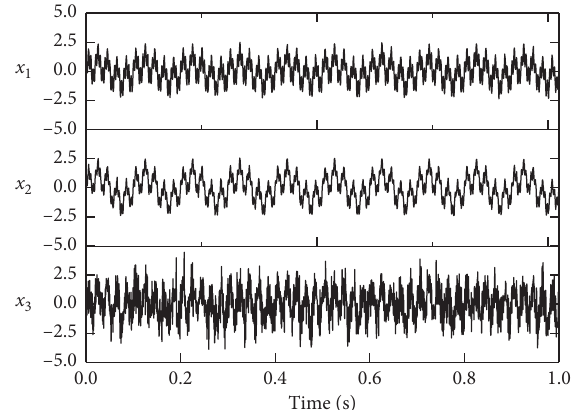
Figure 1: The original signal of simulation.